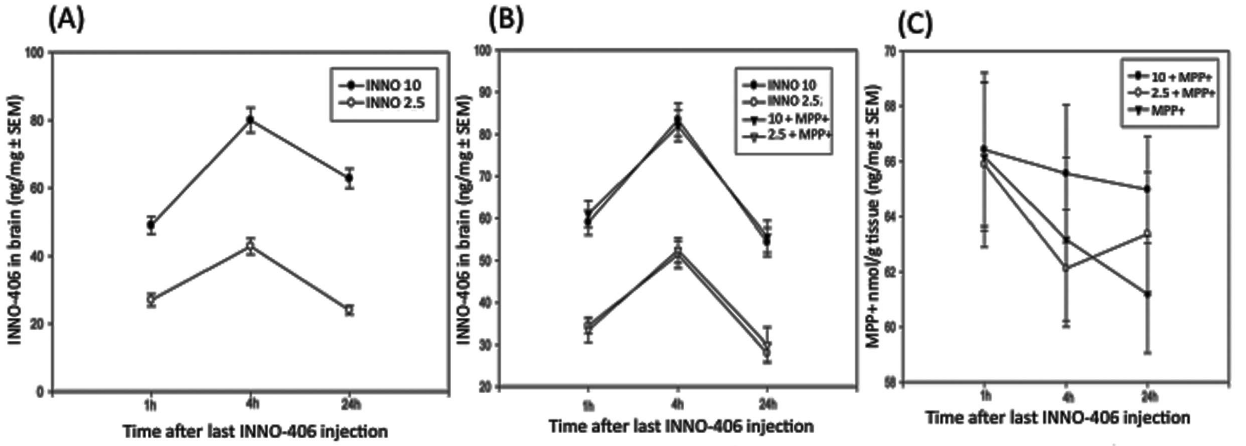
Figure 2. Kinetics of INNO-406 in mouse brain. Brain levels of INNO-406 (2.5 mg/kg/i.p. or 10 mg/kg/i.p.) in C57 mice 1 h, 4 h, and 24 h after a single injection (A). Brain levels of INNO-406 (2.5 mg/kg/i.p. or 10 mg/kg/i.p. after last injection of MPTP) in C57 mice 1 h, 4 h, and 24 h after single injection in the presence or absence of MPTP (4 6 20 mg/kg/i.p. at 2 h interval) (B). Brain levels of MPP + in C57 mice 1 h, 4 h, and 24 h after single injection of MPTP (60 mg/kg/i.p. single injection) in the presence or absence of a single injection of INNO-406 (2.5 mg/kg/i.p. or 10 mg/kg/i.p.)